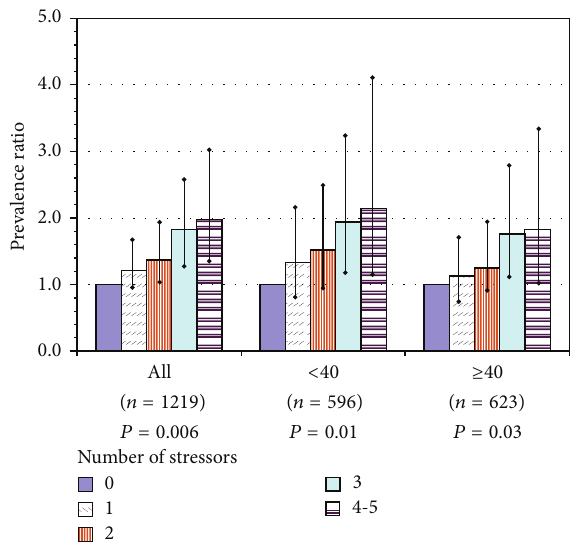
Figure 3: Physical inactivity among U.S. nursing home employees, as a function of number of workplace stressors in the current job, for all participants and by age group: prevalence ratios with 95% confidence intervals for each level above 0 stressors and 𝑃 value for test of linear trend. Index = sum of workplace stressors: poor coworker support, low decision latitude, employer toleration of discrimination, work-family imbalance, and work at night. Models adjusted for gender, education, and region; adjusted for age only in model of all